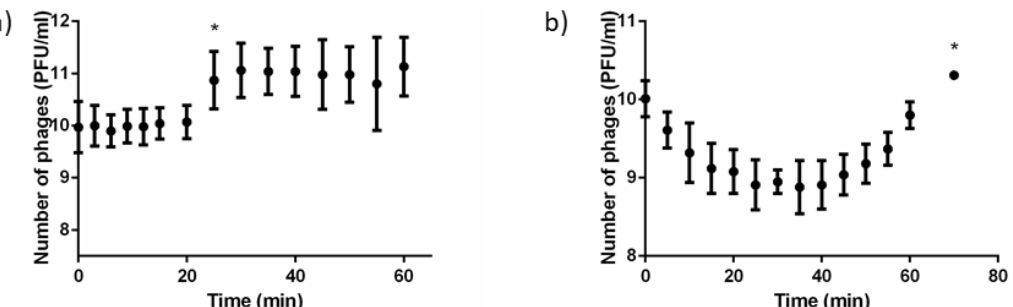
Figure 2. Number of PFUs evaluated during phage infection at a MOI = 50 of ( a ) phage PE3 and ( b ) phage DP1 phage in P. aeruginosa PAO1 cells. Data points represent the mean plus or minus standard deviation of three independent experiments. Statistical differences (* p < 0.05) were analyzed with one-way ANOVA with Tukey’s honest significant difference post hoc